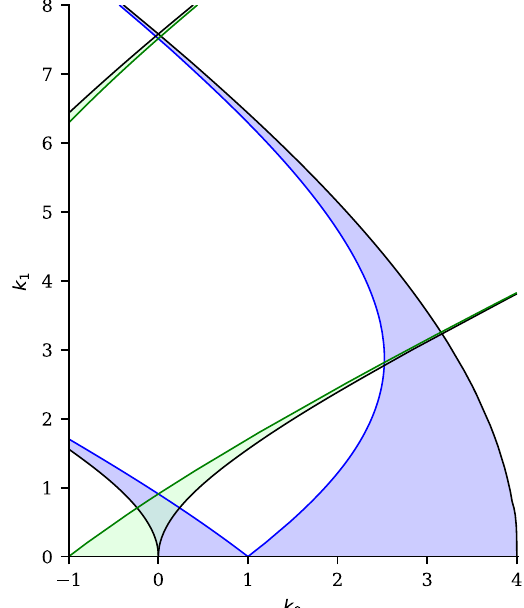
FIG. 1. Stability diagram in the ð k 0 ; k 1 Þ plane. Blue-shaded regions are stable for horizontal motion, with the blue line 0 . 5 . Green-shaded regions are stable for vertical indicating ν x ¼ 0 . 5 . The region motion, with the green line indicating ν y ¼ overlaps are stability islands.